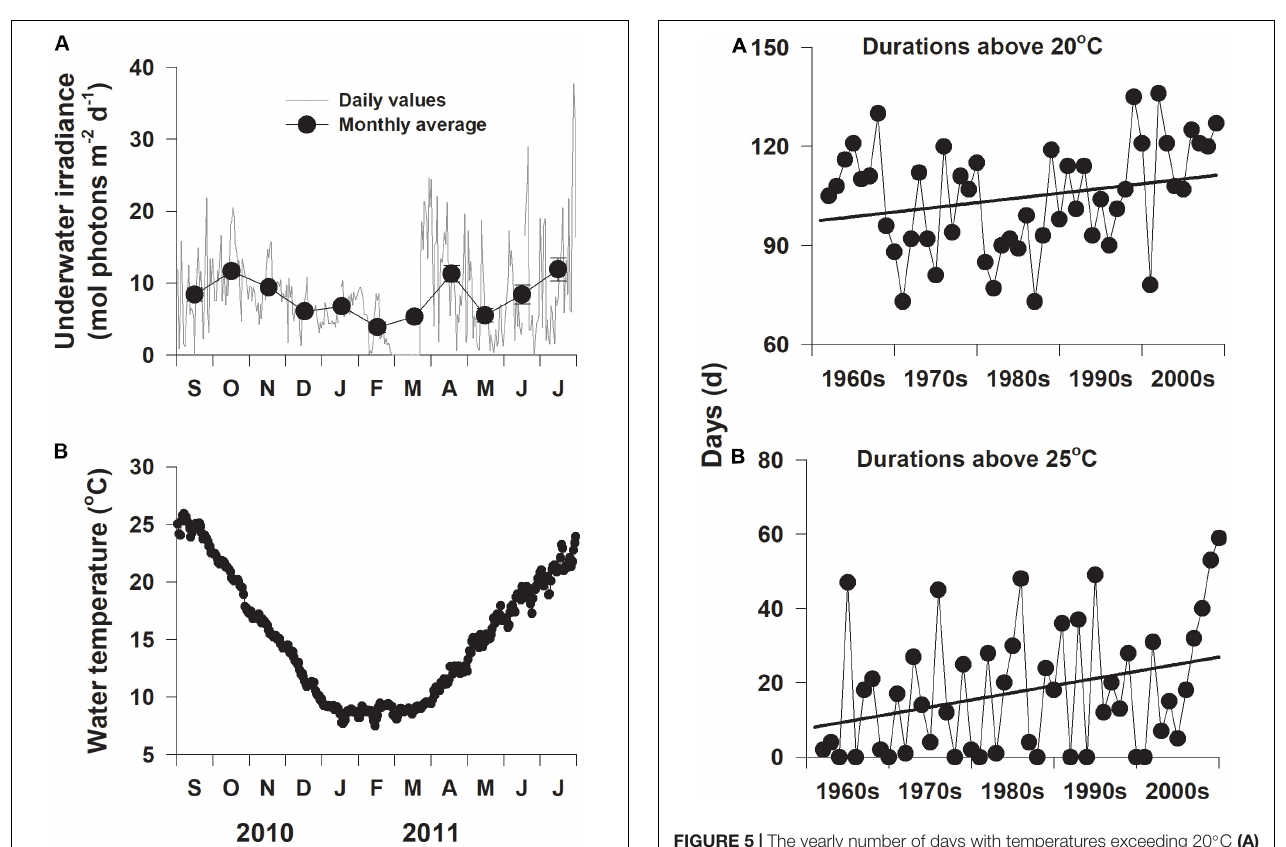
FIGURE 5 | The yearly number of days with temperatures exceeding 20 ◦ C (A) and 25 ◦ C (B) on the southern coast of Korea since the